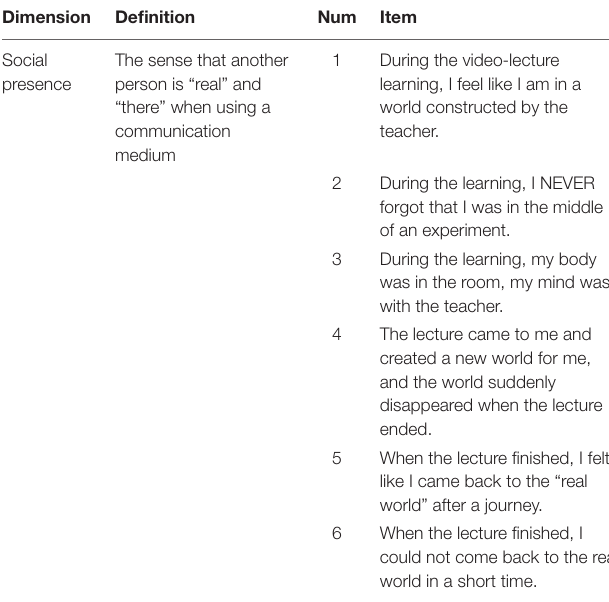
TABLE 1 | The six-item questionnaire for the measurement of perceived social